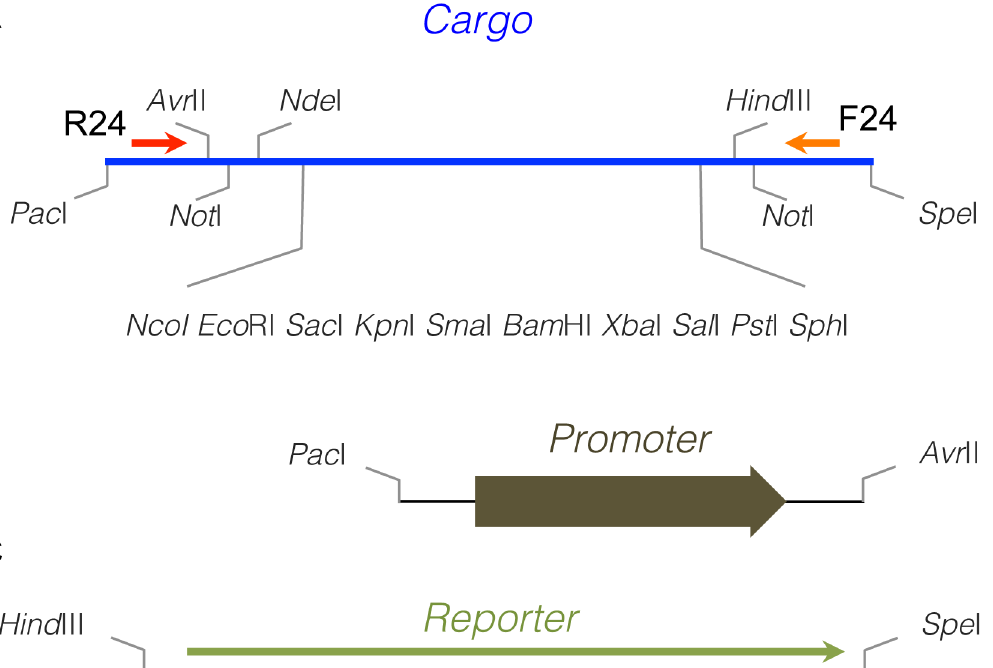
Fig 2. Schematic representation of the cargo architecture. ( A) The basic cargo is a 150 nt long sequence containing an extensive multiple cloning site and a pair of universal primers (F24 and R24), allowing the user to easily clone and check the sequence of interest. ( B) The expression systems of the pHsal series are cloned as Pac I/ Avr II fragments at the 5 ’ -end of the MCS. ( C) The reporter systems for promoter probing are cloned as Hind III/ Spe I fragments at the 3 ’ -end of the MCS. With this design, the fragments of interest could be cloned using any of the restriction sites from Avr II to Hind III, always considering the directionality of the expression and reporter